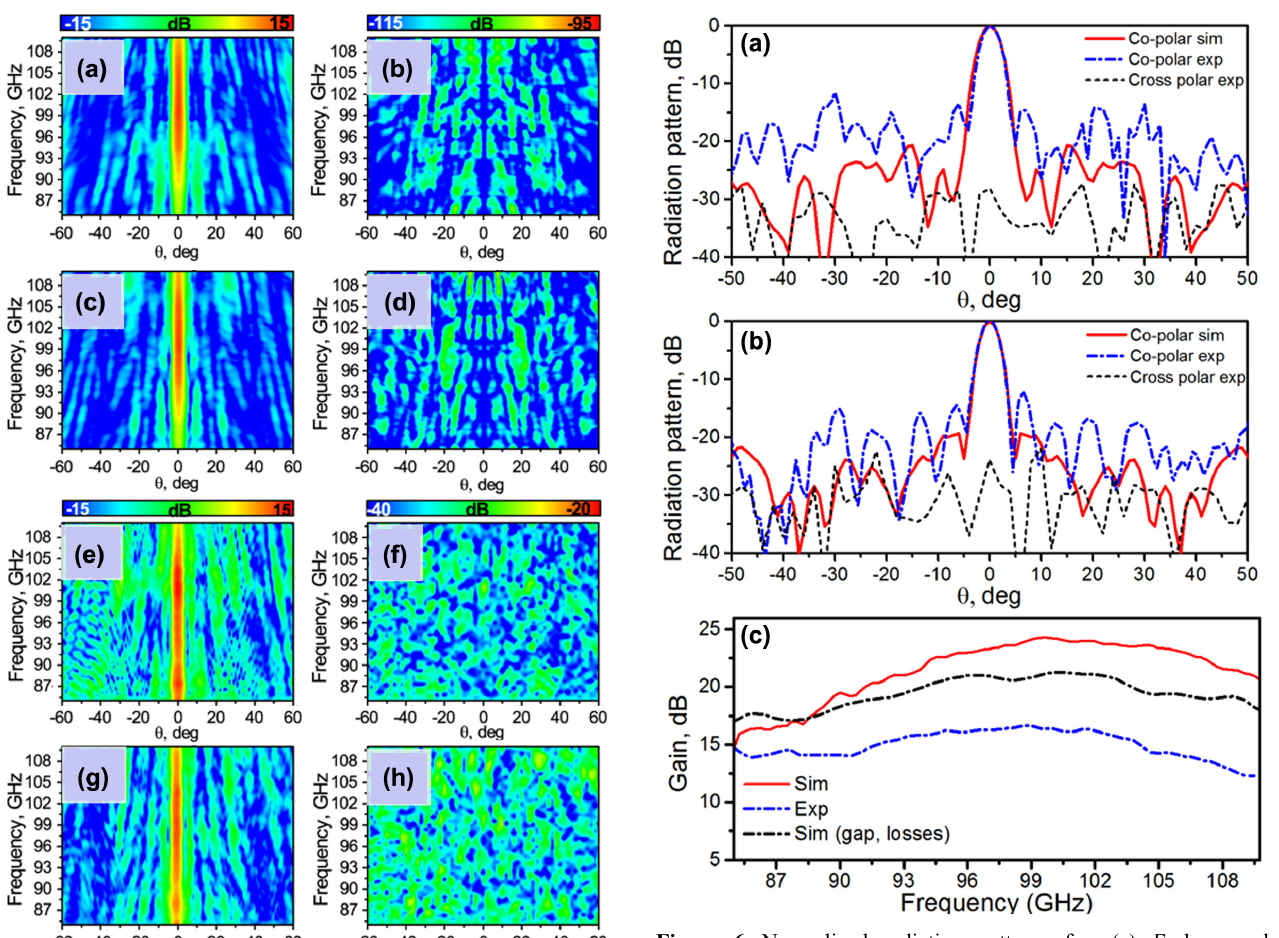
Figure 6. Normalized radiation patterns for: (a) E -plane and (b) H -plane at frequency 99 GHz (simulation and experimental). (c) Simulation gain (solid red line), experimental gain (dash dotted blue line) and simulation gain, considering air gaps, larger diameter a of subwavelength holes and losses (dash dotted black